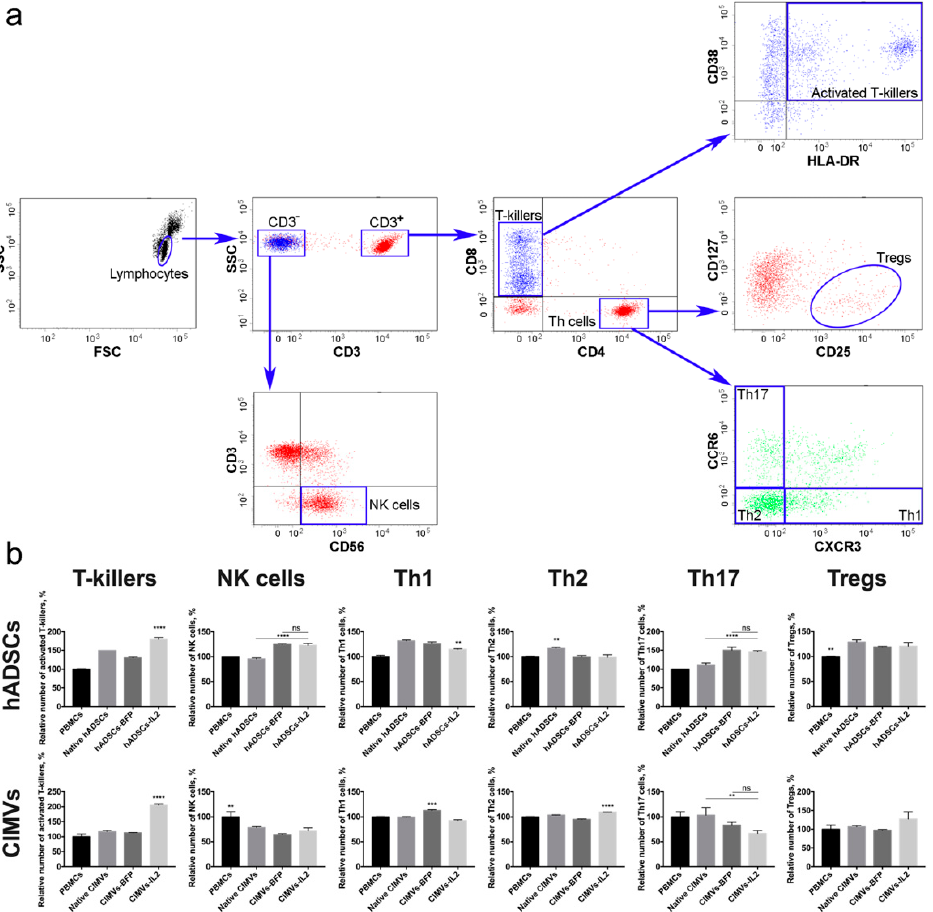
Figure 6. ( a ) Gating strategy for flow cytometry of immune cells to analyse the following populations: CD3 + CD8 + CD4 − CD38 + HLA-DR + T-killers, CD3 − CD56 + NK cells, CD3 + CD4 + CD8 − CCR6 − CXCR3 + Th1 cells, CD3 + CD4 + CD8 − CCR6 − CXCR3 − Th2 cells, CD3 + CD4 + CD8 − CCR6 + CXCR3 − Th17 cells, CD3 + CD4 + CD8 − CD25 + CD127 low Tregs. ( b ) The cultivation of CD8 + T-cells with hASDCs-IL2 and CIMVs-IL2 led to a significant increase in the number of activated CD38 + HLA-DR + T-killers. However, the cultivation of peripheral blood mononuclear cells (PBMCs) with CIMVs-IL2 led to a more significant (2-fold) increase in the number of activated T-killers compared to hADSCs-IL2 cells (by 1.3 times). The number of NK cells did not increase after culturing with hADSCs, and decreased after incubation with CIMVs. Small changes (both an increase and a decrease) in the number of Th cells were observed in various samples, both native and genetically modified. At the same time, CIMVs-IL2 did not increase the number of regulatory T-cells (Tregs), unlike hADSCs-IL2. Each box represents the mean ± SD ( n = 4) of four biological replicates, the data were calculated as relative to control PBMCs. ** p < 0.01, *** p < 0.001, **** p < 0.0001.